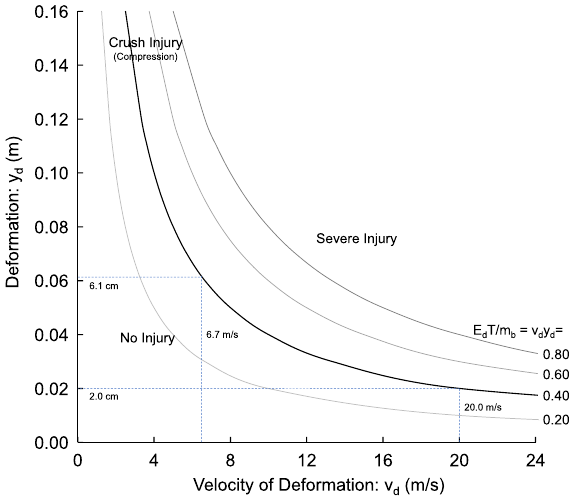
Figure 15. Iso-energy curves related to the intrusion velocity loading and deformation of the